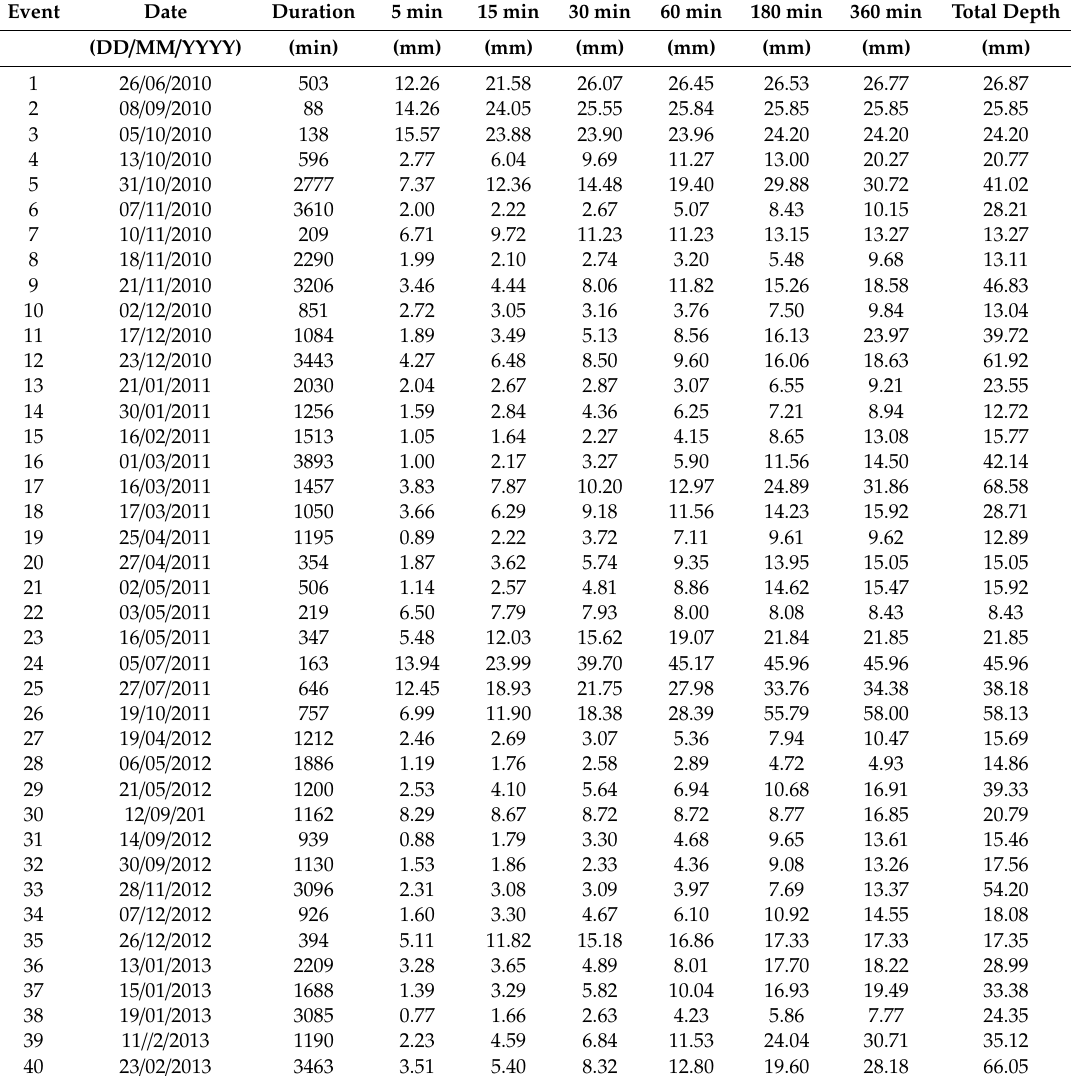
Table A1. Basic characteristics of the potential erosive events considered in this study, calculated using a moving window for each time